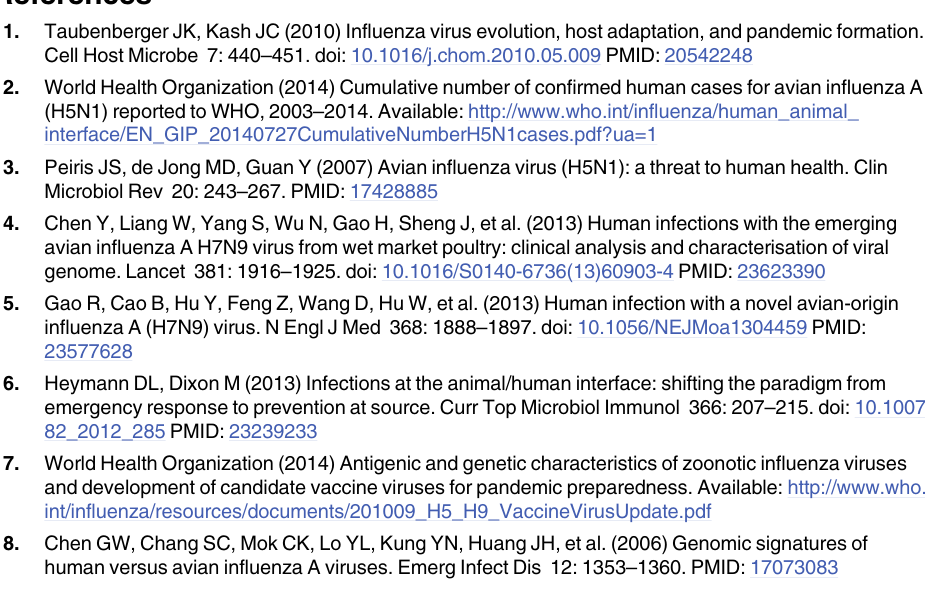
S1 Table. Distribution of human NS2 proteins across various avian influenza